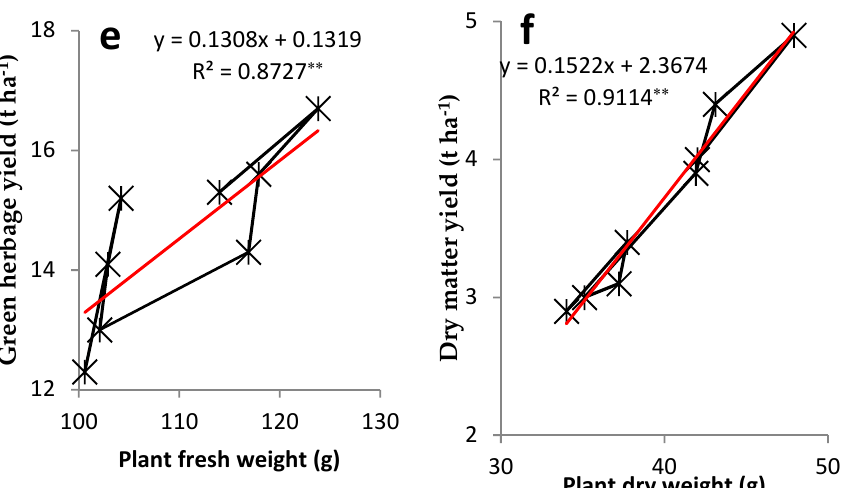
Figure 5. Correlation analyses depicting the relationship between herbage yield and yield attributes such as ( a ) plant height ( a ), stem girth ( b ), leaf area per plant ( c ), number of leaves per plant, ( d ) leaf area per plant, ( e ) fresh weight per plant and ( f ) dry weight per plant. ** and * show highly significant and moderate significant differences at P= 0.05 respectively.